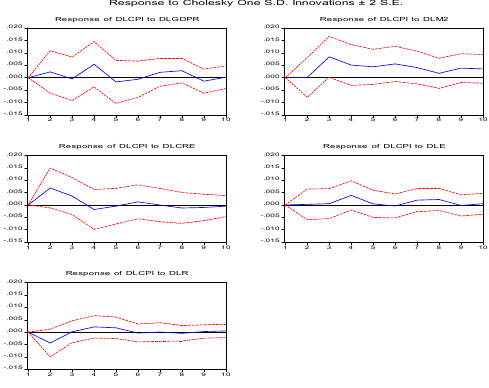
Fig. 3. Response of CPI after different shocks